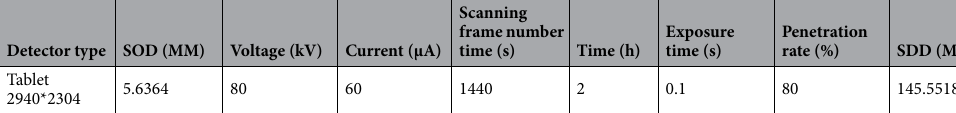
Table 6. Scanning parameters of X-ray 3D microscope.